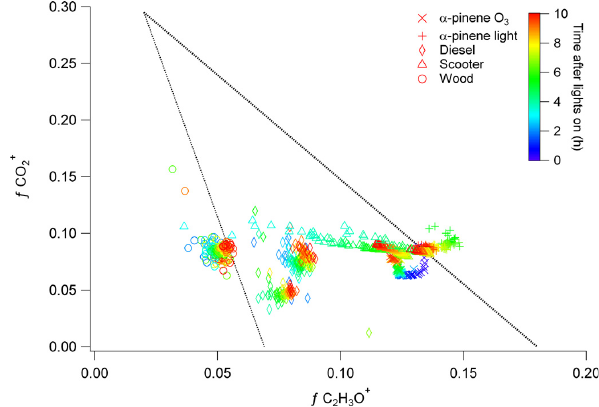
Fig. 5. Fraction of the high resolution fit f CO + ( f 44 vs. f 43). The triangular space found by Ng et al. (2010) to accommodate the OOA component of ambient organic aerosol is shown as